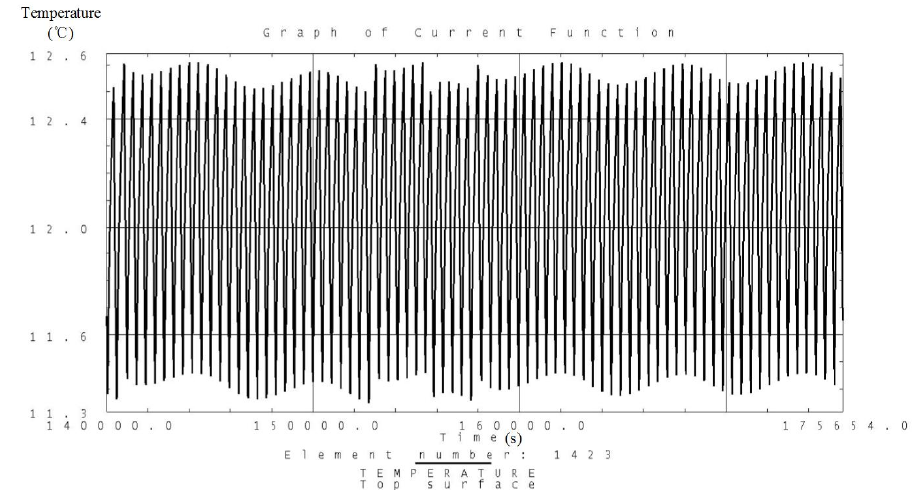
Figure 7. Analysis result of the temperature variation curve of the camera under high temperature conditions.